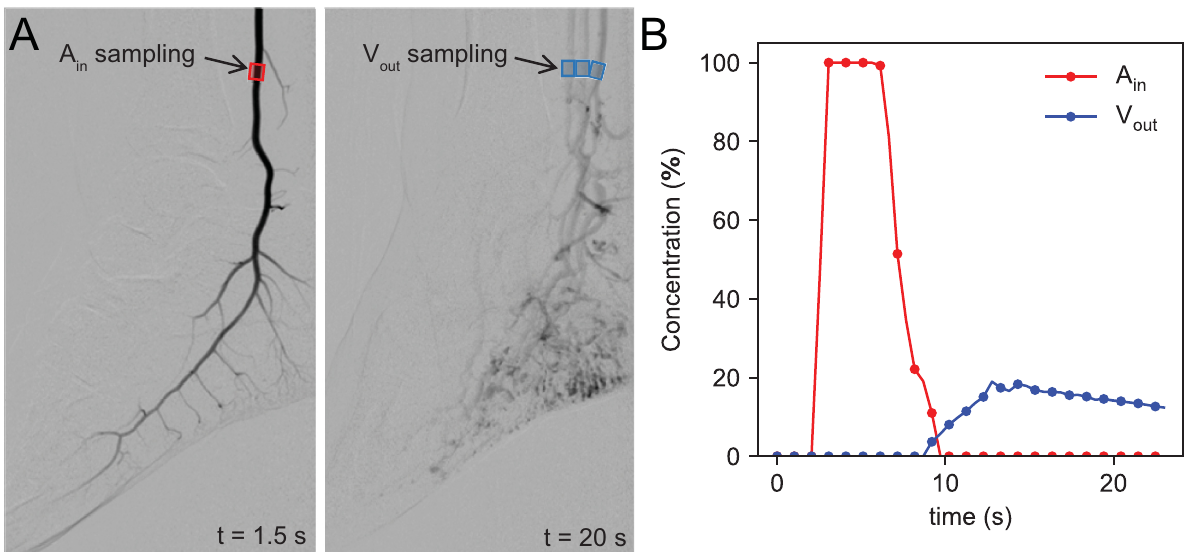
Fig 3. Example of concentration measurements in DSA recordings. (A) Arterial and venous sampling ROIs, (B) normalized CA intensity evolution for ROIs depicted in A.